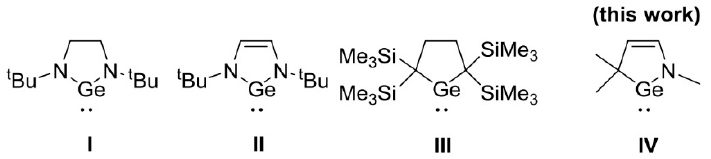
Figure 1. Selected examples of structurally characterized germylenes I – III featuring five-membered ring skeleton, and this work.